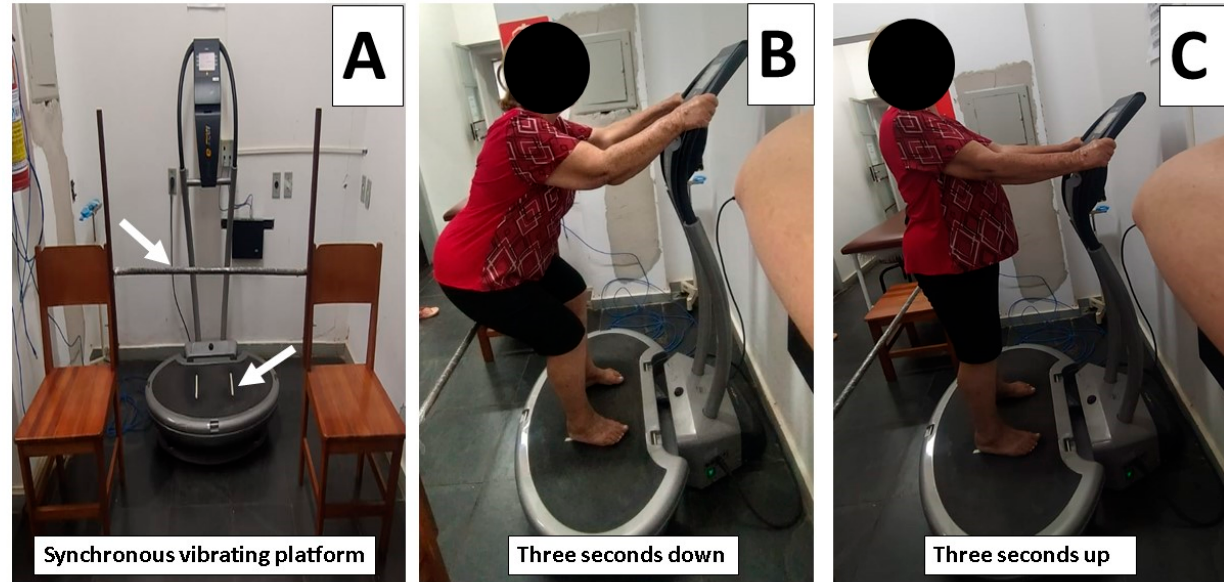
Table 1. Whole-body vibration training load program (adapted from [27]).